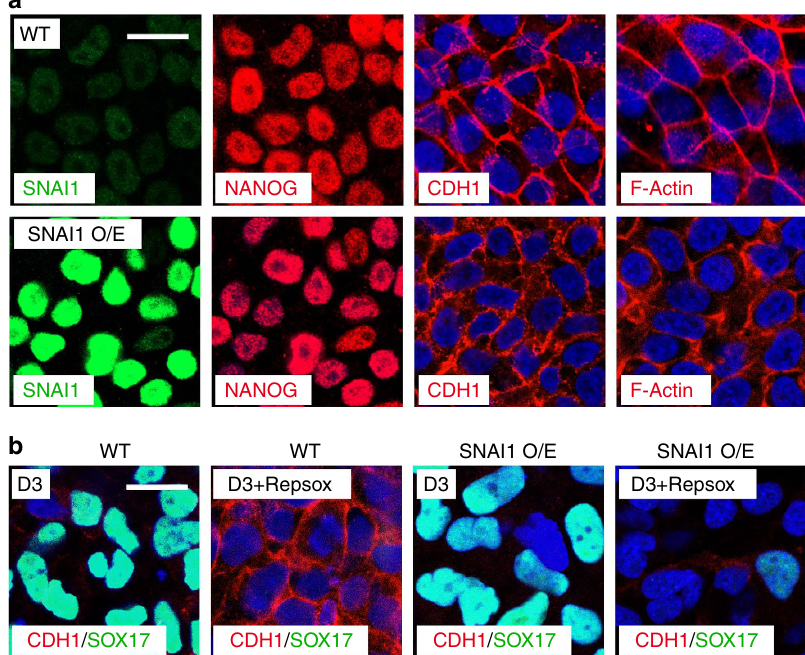
Figure 7 | Analysis of pluripotency and DE formation in the SNAI1 overexpression hESCs. ( a ) hESCs overexpressing SNAI1 (SNAI1 O/E) show normal staining pattern for NANOG, CDH1 or F-Actin. Scale bar, 20 m m. ( b ) Immunofluorescence staining of CDH1 and SOX17 after Activin A treatment in the presence or absence of Repsox in WT and SNAI1 overexpression hESCs (SNAI1 O/E). Scale bar, 20 m